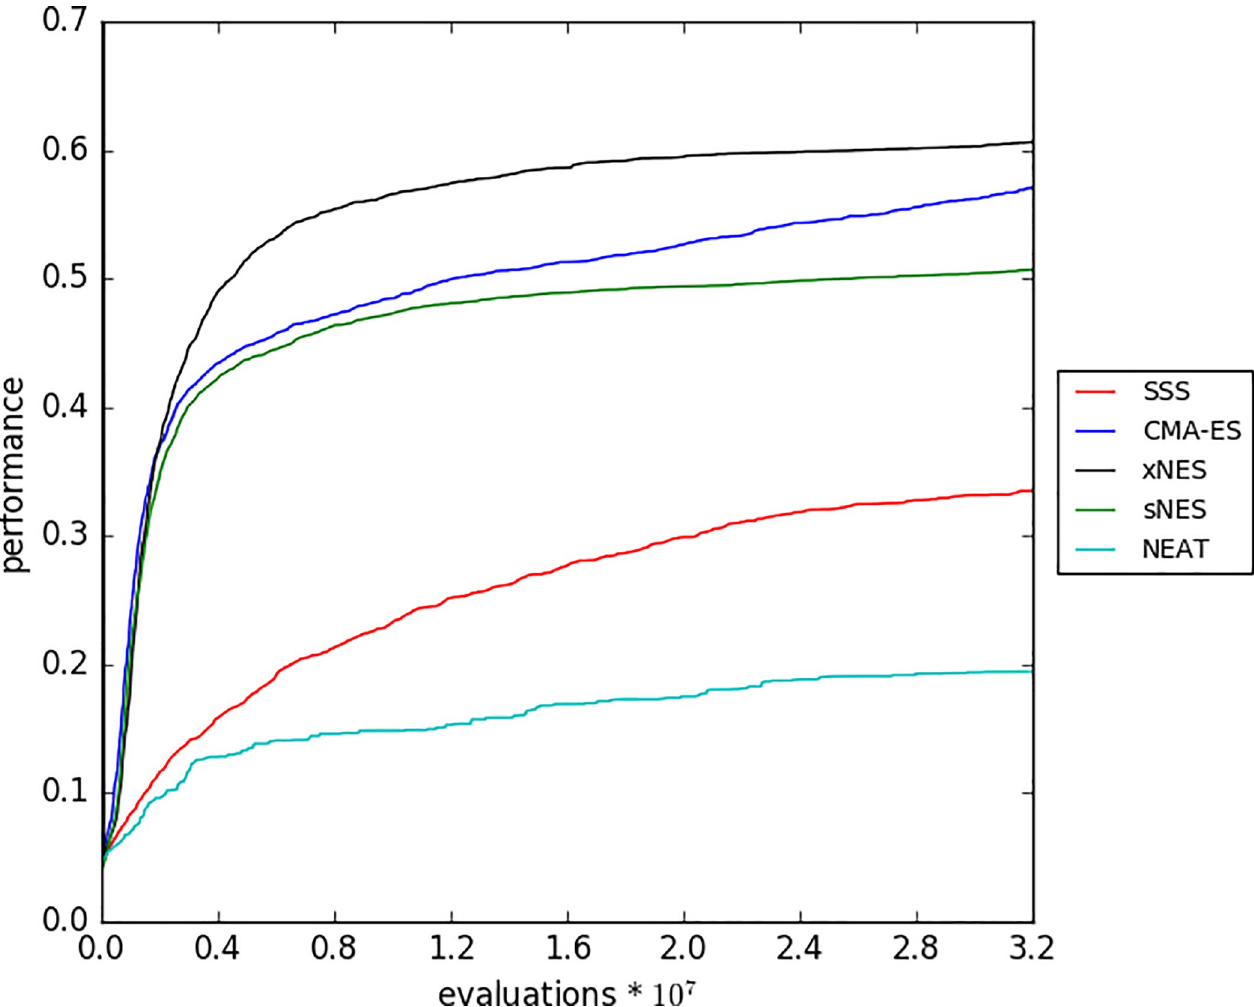
Fig 7. Performance of the best candidate solution so-far across generations for different methods. The X-axis indicate evaluations. Data obtained in the experiments with the best combination of parameters (see caption of Fig 6). Each curve indicates the average results of 40 replications.